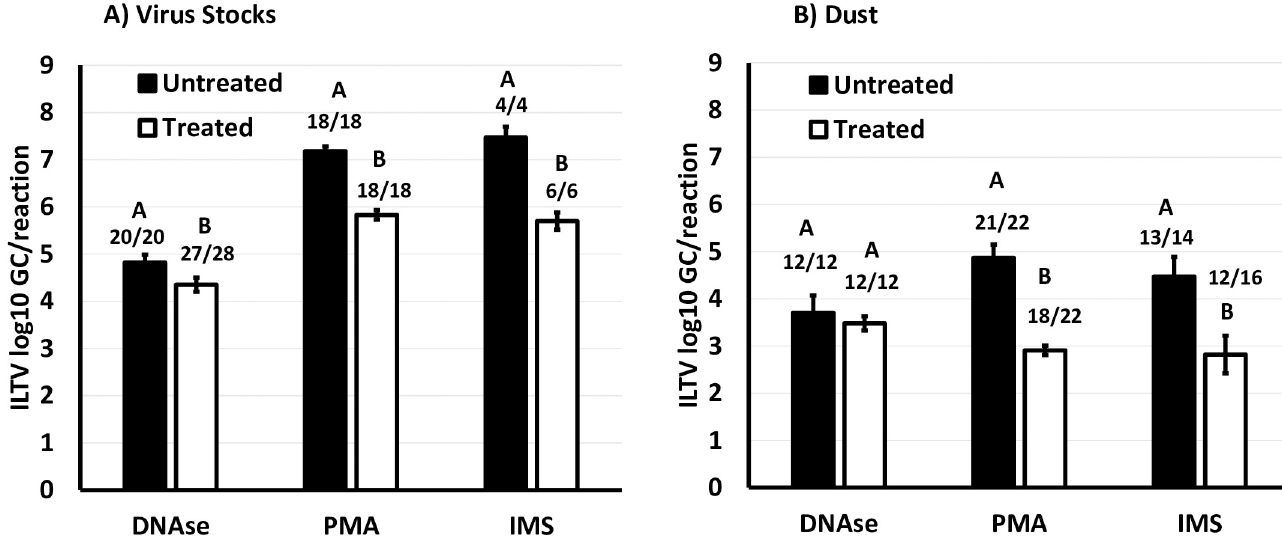
Fig 2. Effect of DNAse, IMS and PMA pre-treatments in ILTV GC. ILTV log 10 GC (LSM ± SE) in DNAse, IMS and PMA treated and untreated virus stocks (A) and naturally ILTV DNA positive dust (B). Number of positive samples and total number of samples are also given. Superscripts (ABC) not sharing the same letter denote difference (p < 0.05) between